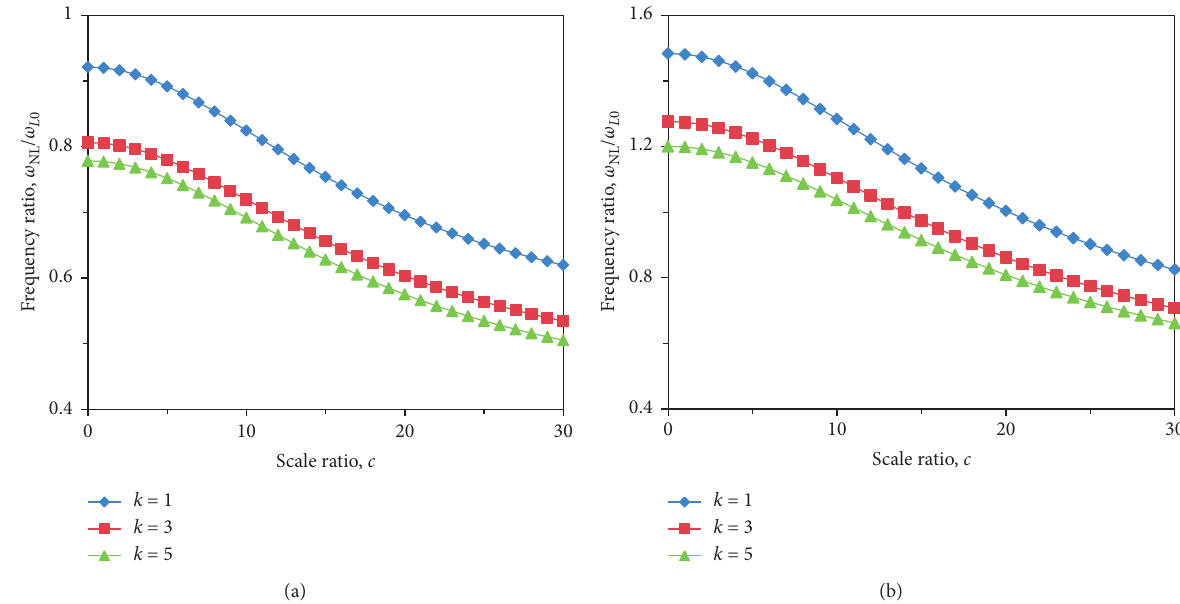
Figure 11: The variation of the frequency ratios of the FG nanobeams to the scale ratio for β � 0 . 02, L / h � 20, and V thickness effect; (b) with thickness effect.